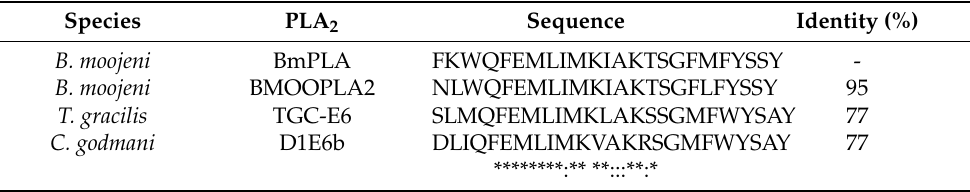
Table 1. Multiple alignment of PLAs N-terminal demonstrated region of similarity with BmPLA. PLA 2 from B. moojeni venom; Tgc-E6 from Tantilla gracilis venom and D1E6b from Cerrophidion godmani venom, with a 77% identity. Positions with fully conserved residue (*); One of the high-scoring groups is conserved (:).